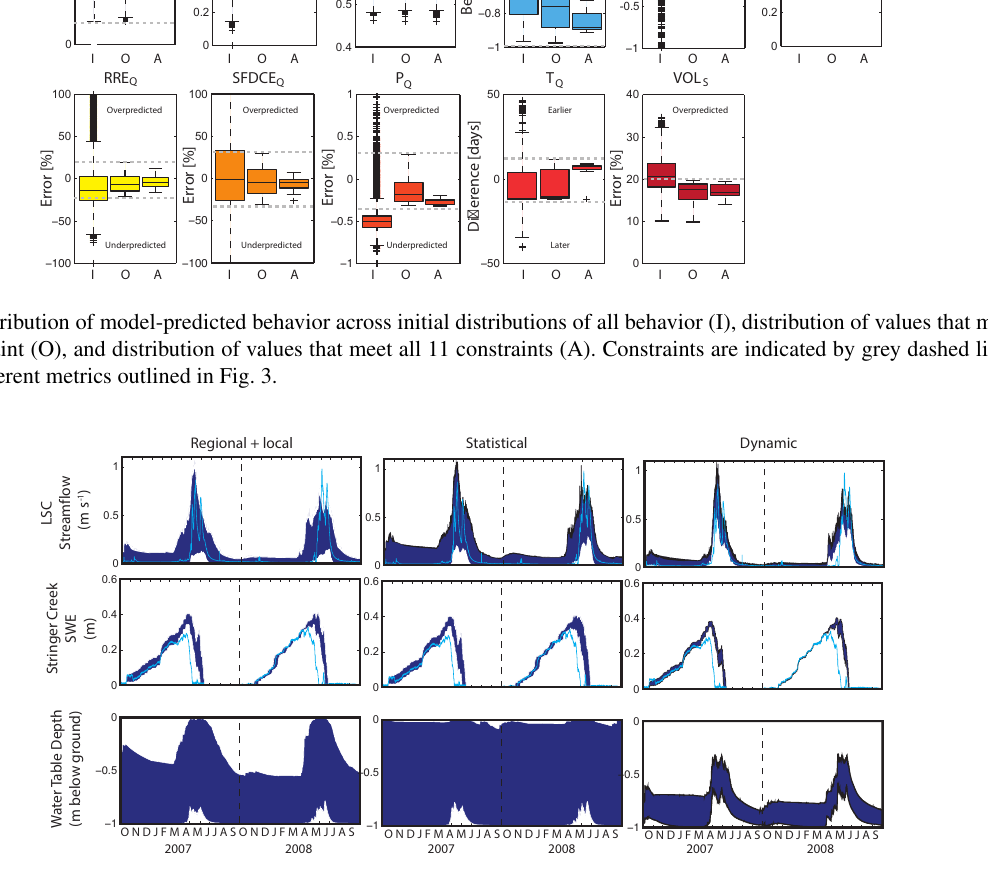
overestimated the time that the last of the snowpack melted during late May and early